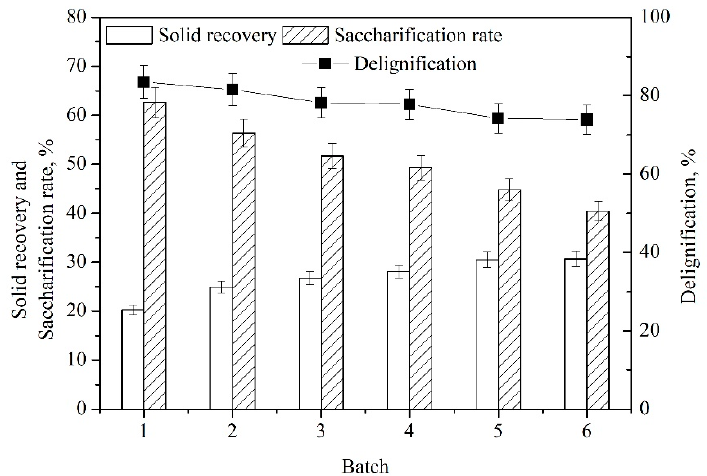
Figure 7. Reuse of pretreatment medium NaOH–ChCl:UA-TA [Pretreatment condition: NaOH (7 wt%)–ChCl:UA-TA (8 wt%), 75 °C, 60 min; Enzymatic hydrolysis condition: cellulase (10.0 FPU/g TS) and xylanase (30.0 CBU/g TS), 50 °C, pH 4.8].